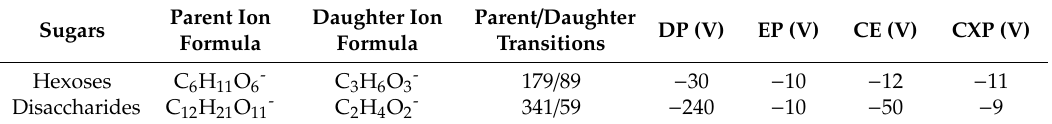
Table 1. Mass spectrometry parameters for the detection of sugars. DP: Declustering potential, EP: Entrance potential, CE: Collision energy, CXP: Collision cell exit potential, are described for hexoses and disaccharides. Parent and daughter ion formulas were reported by Calvano et al. [25].